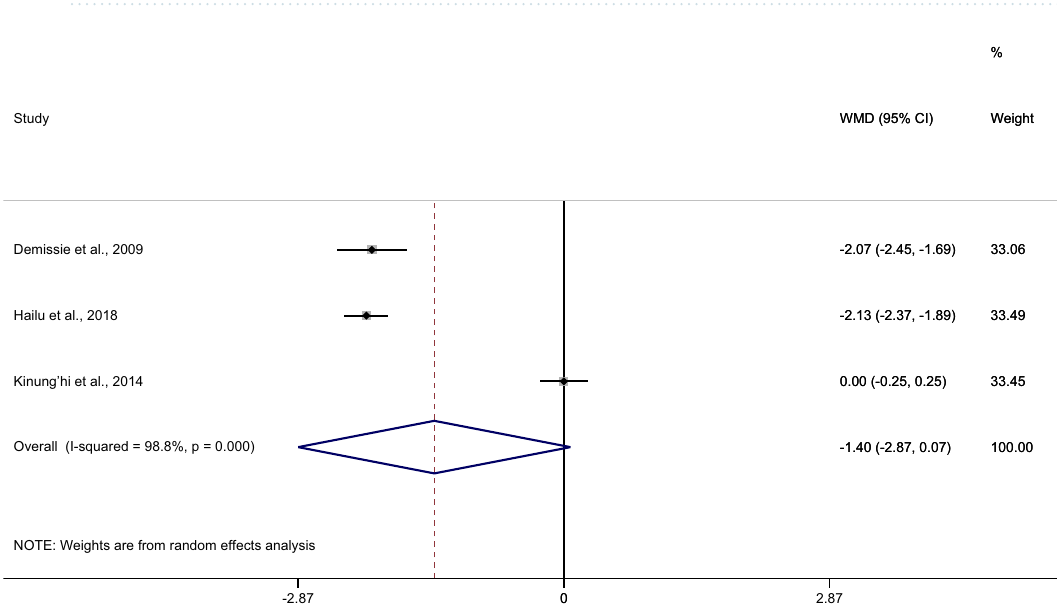
Figure 7. Mean hemoglobin levels between patients with Plasmodium spp. and hookworm co-infection and patients without any infection. WMD weighted mean difference, CI confidence